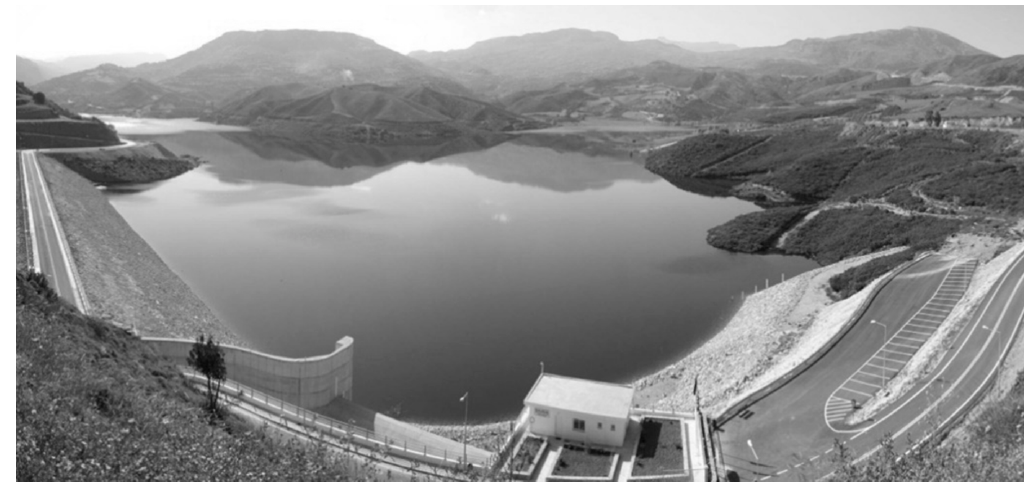
Figure 6. The existing dam at the site “Potamon”, Amari, Prefecture of Rethymnon, Crete, Greece.